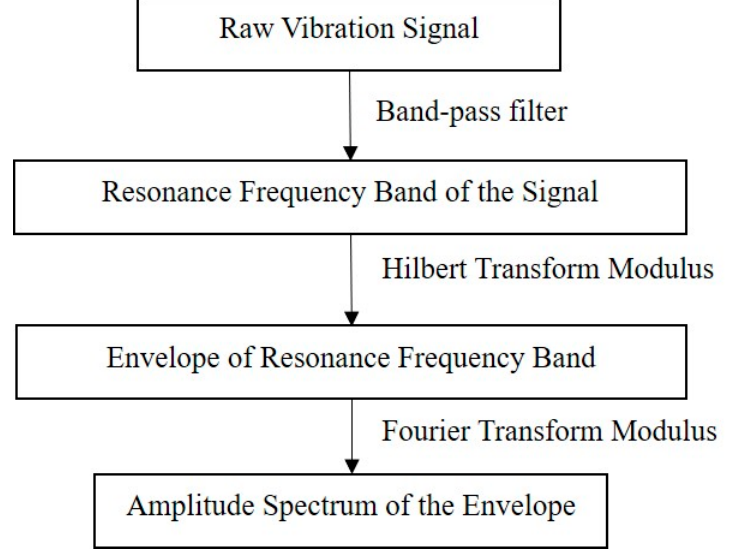
Figure 1. Envelope analysis with the Hilbert and Fourier transforms.